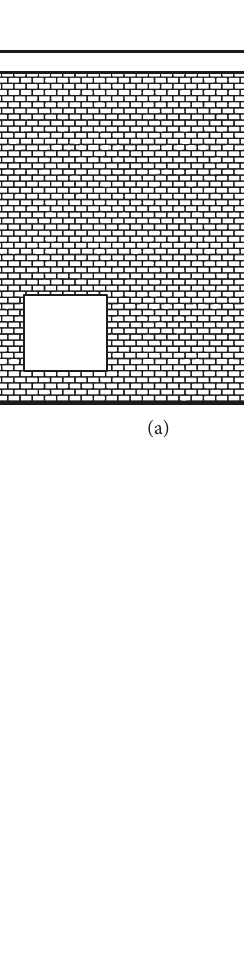
Figure 9: Action patterns of flexible connection and rigid connection.